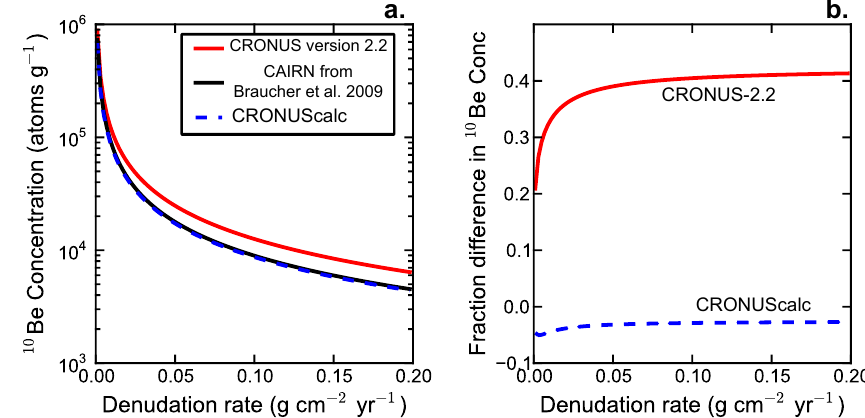
Figure 9. Concentrations as a function of denudation rate (a) and the fractional differences between the predicted concentration from the Braucher et al. (2009) approximation used in CAIRN and both CRONUS-2.2 (Balco et al., 2008) and CRONUScalc (Marrero et al., 2016) (b) . These concentrations are calculated for a hypothetical site at 70 ◦ N and near sea level (1007hPa). Note that although the default production scheme in CAIRN is the Braucher et al. (2009) scheme, the production from CRONUScalc (Marrero et al., 2016) can also be used (see Table 4).